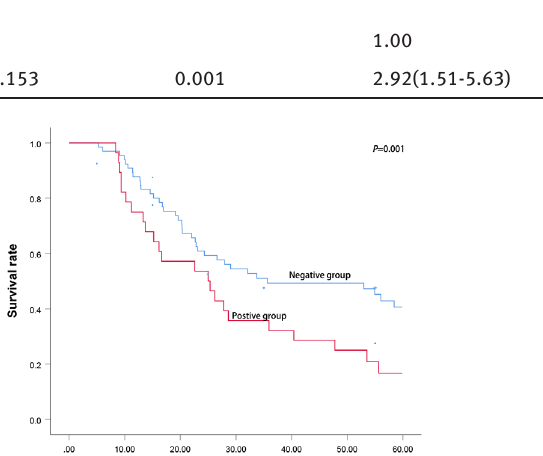
Figure 2: Relationship between NLRC5 expression and prognosis